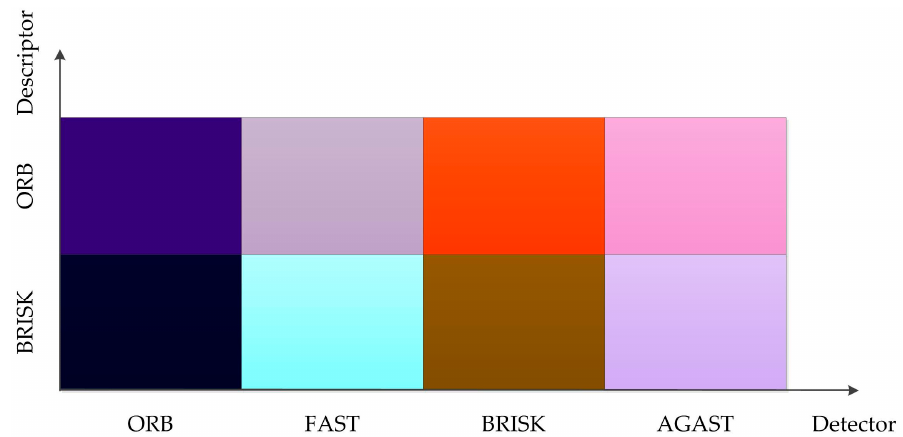
Figure 5. Performance comparison of different combination pairs.